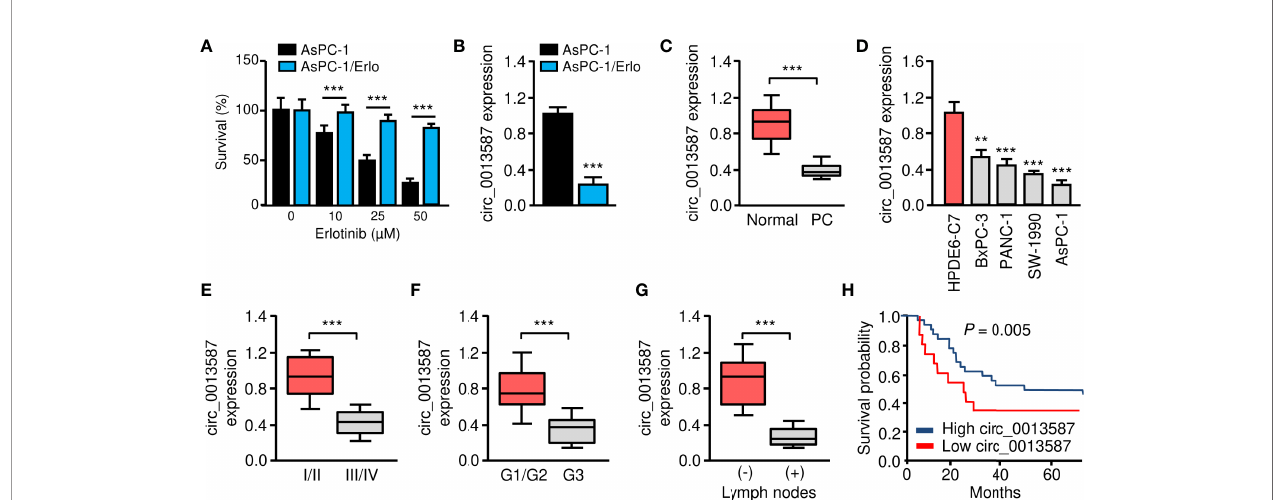
FIGURE 1 | Circ_0013587 expression is down-regulated in erlotinib-resistant AsPC-1 cells. (A) Effect of erlotinib treatment (48h) on the survival of erlotinib-sensitive AsPC-1 cells and erlotinib-resistant AsPC-1/Erlo cells was analyzed using CCK-8 assay. (B) The qRT-PCR assay showed signi fi cant down-regulation of circ_0013587 expression in AsPC-1/Erlo cells than in AsPc-1 cells. (C) qRT-PCR analysis of circ_0013587 levels in pancreatic cancer (PC) and adjacent normal tissues. (D) qRT-PCR analysis of circ_0013587 expression in four pancreatic cancer cell lines and a normal pancreatic cell line HPDE6-C7. (E – G) The expression of circ_0013587 in pancreatic cancer patients with different tumor stages (E) , different tumor grades (F) , and patients with (or without) lymph node metastasis (G) . (H) Kaplan-Meier analysis of overall survival in pancreatic cancer patients with high (above median) versus low (below median) circ_0013587 levels. ** P < 0.01, *** P <0.001.